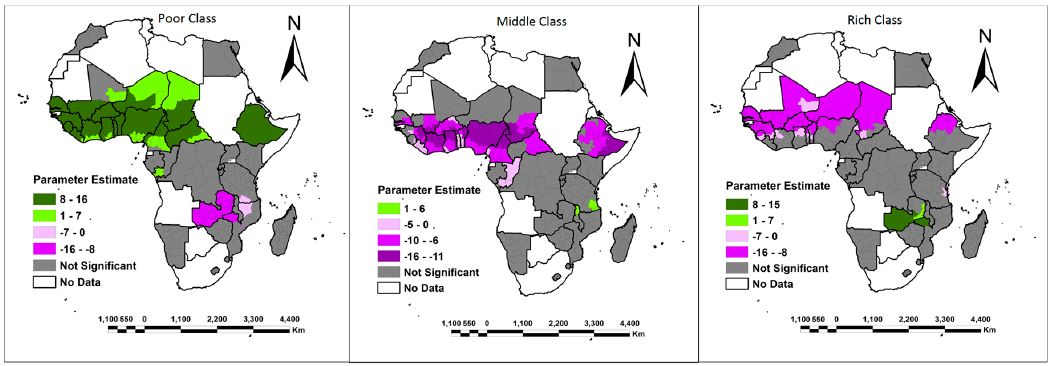
Figure 14. Spatial distribution and significance of wealth class on women’s access to family land.